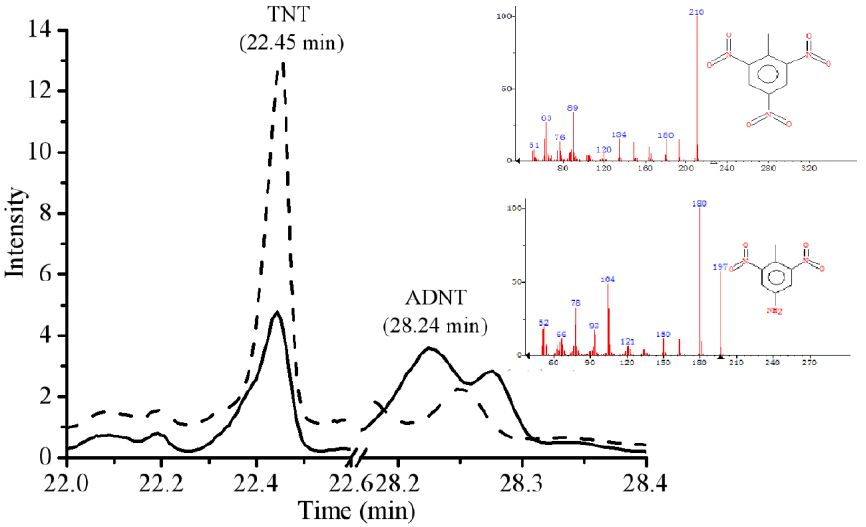
Figure 6. GC-MS analysis of TNT metabolite following degradation. The figure shows peaks of TNT